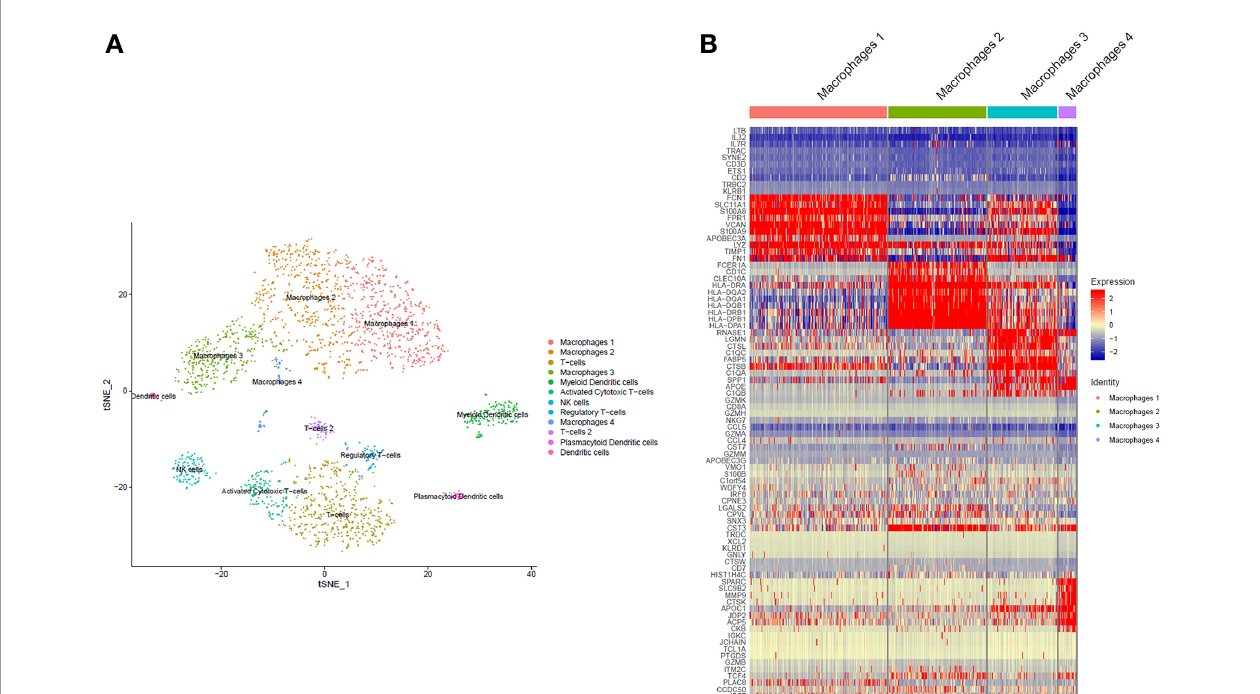
FIGURE 1 | Single cell RNA sequencing. The clustering of predicted cell subpopulations from SF cells of 3 PsA patients identi fi ed 12 different cell populations, with the most dominant being monocytes/macrophages (A) . The monocytes/macrophages were comprised of four subpopulations, three of which were large (macrophages 1, 2 and 3) with expression levels of unique cell markers and transcriptomic signatures. The expression of top differentially expressed genes within the monocyte/macrophage subpopulations is shown in (B)